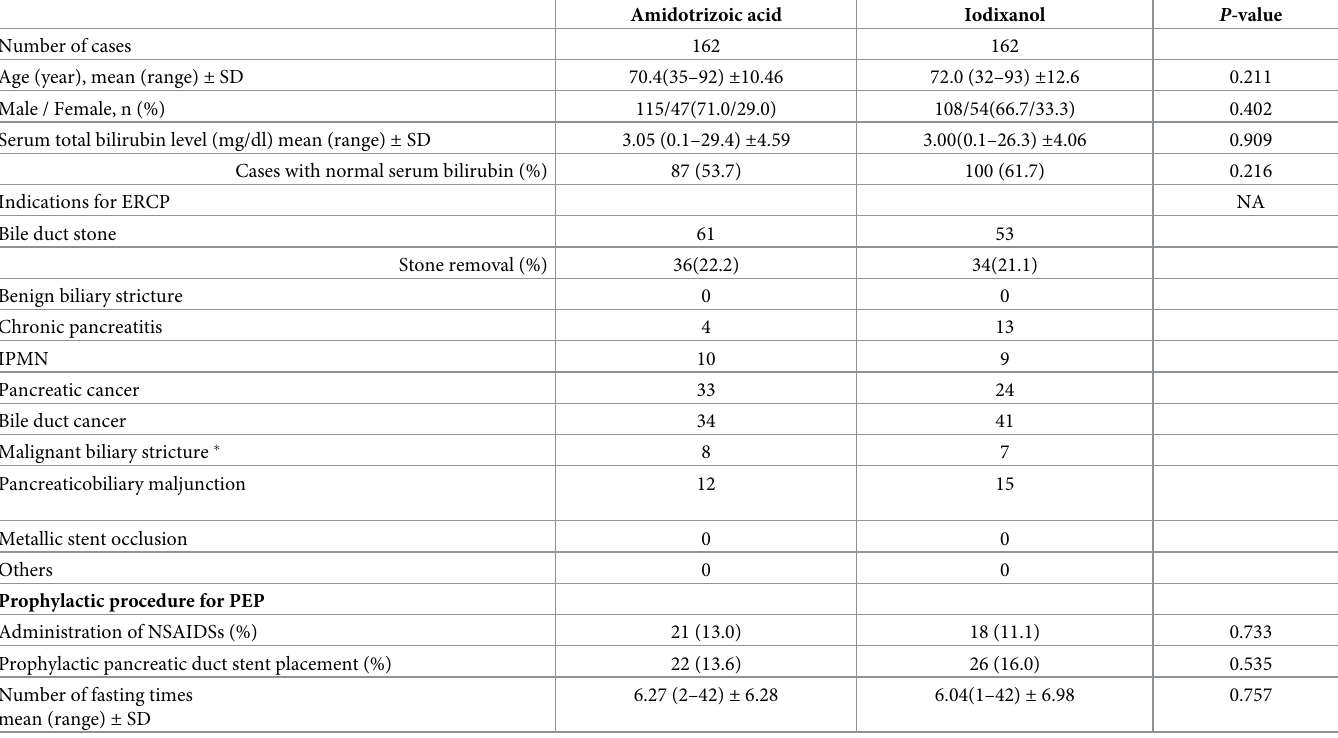
Table 3. Clinical characteristics of patients after propensity score matching.